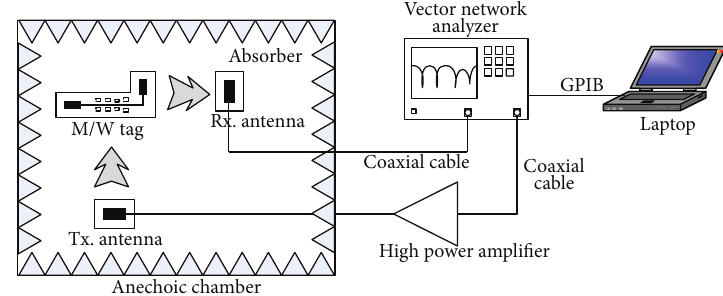
Figure 7: Interrogating system set up for wireless transmission